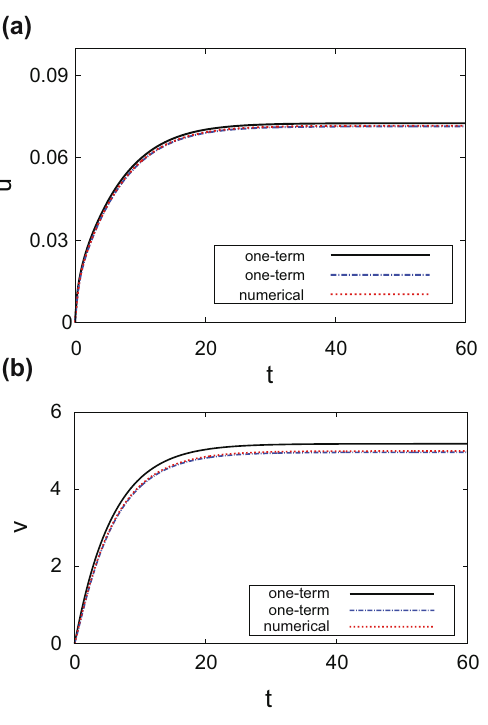
Figure 9: The time evolutions for u ( a ) and v ( b ) against t at x 0 = . The parameter values used are λ 0.02 =